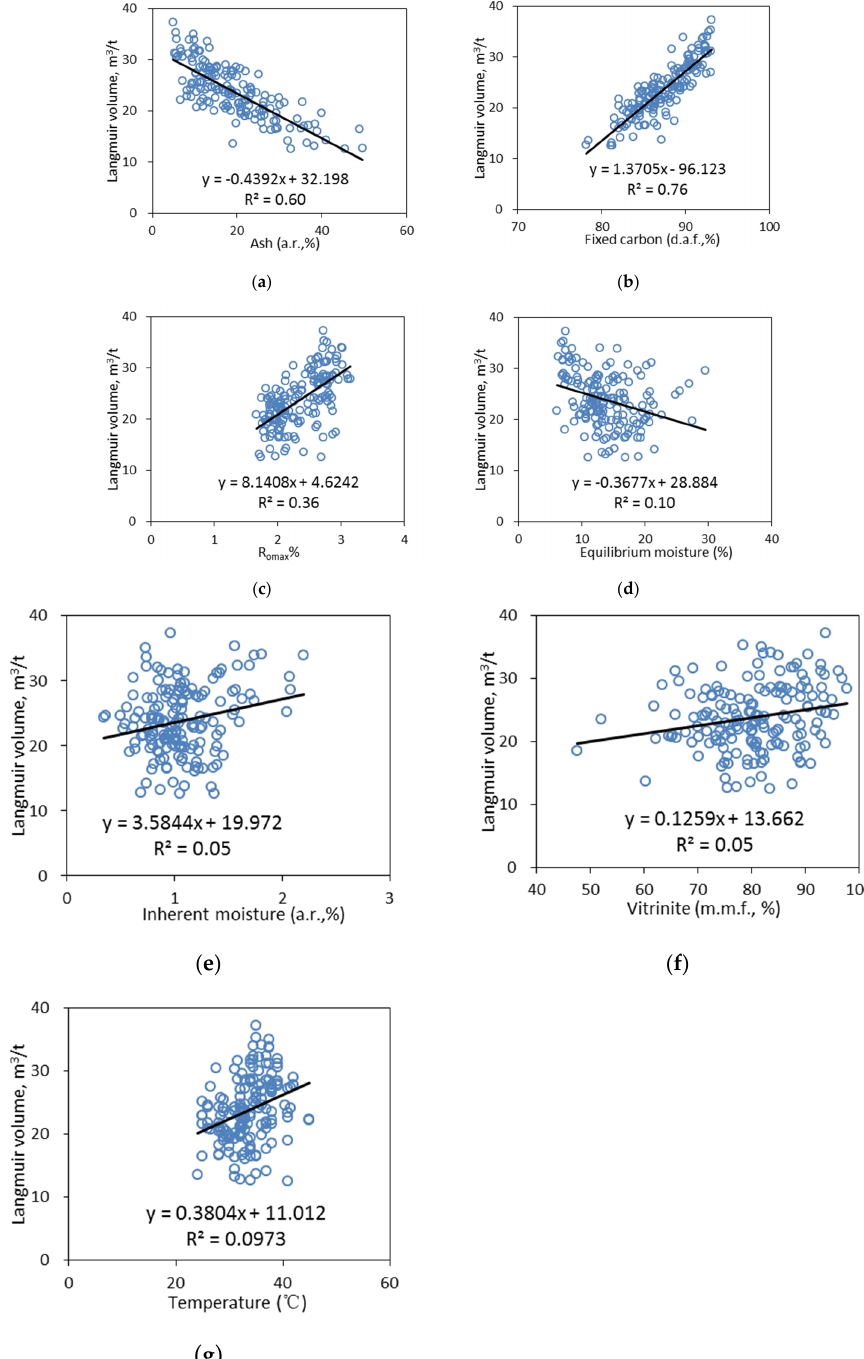
Figure 4. Correlation analysis of input features with the adsorption capacity represented with Langmuir volume. ( a ) ash (a.r.); ( b ) fixed carbon (d.a.f.); ( c ) vitrinite reflectance; ( d ) inherent moisture (a.r.); ( e ) equilibrium moisture; ( f ) vitrinite (m.m.f) and ( g ) temperature.